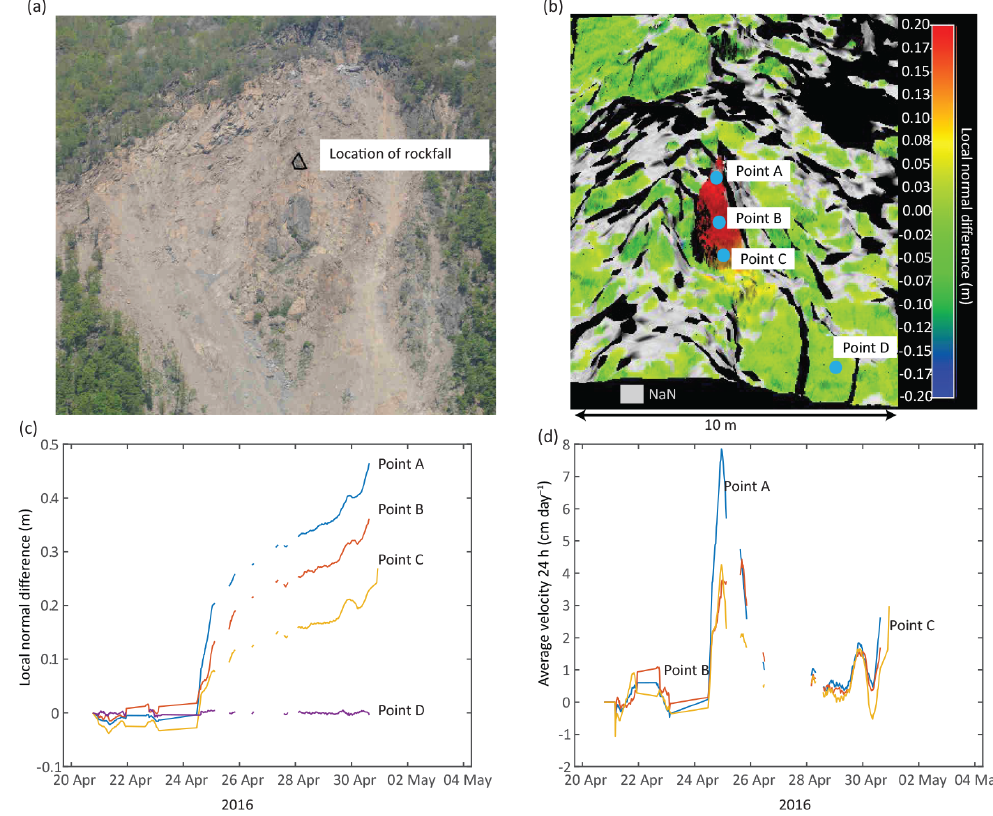
Figure 12. Pre-failure deformation of 80m 3 rockfall. (a) Location of 80m 3 rockfall. (b) Point cloud with mapped change showing defor- mation of the rock block prior to failure and four points used to plot time series data. Points A, B and C are located on the deforming area and Point D is located on an adjacent stable area of slope. (c) Deformation time series (cumulative values) of three points on the surface of the deforming rock block and a nearby stable point. (d) Average 24h velocity for Points A, B and